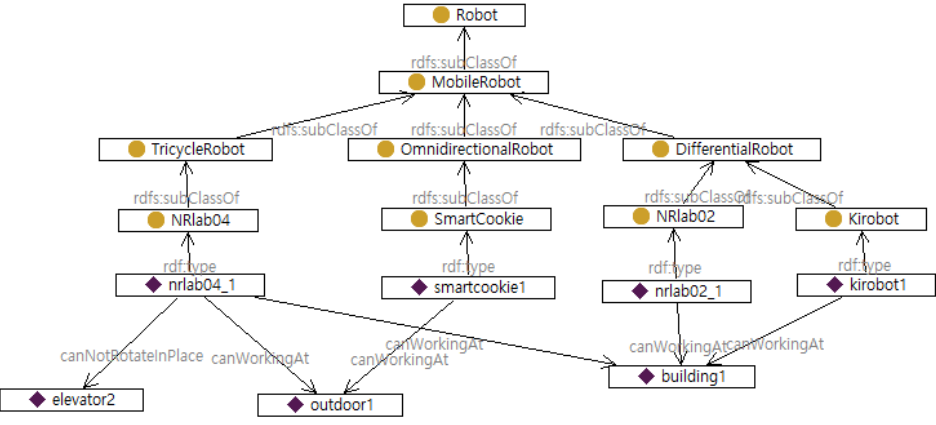
Figure 4. Subclasses of Robot and some of their individuals’ asserted object